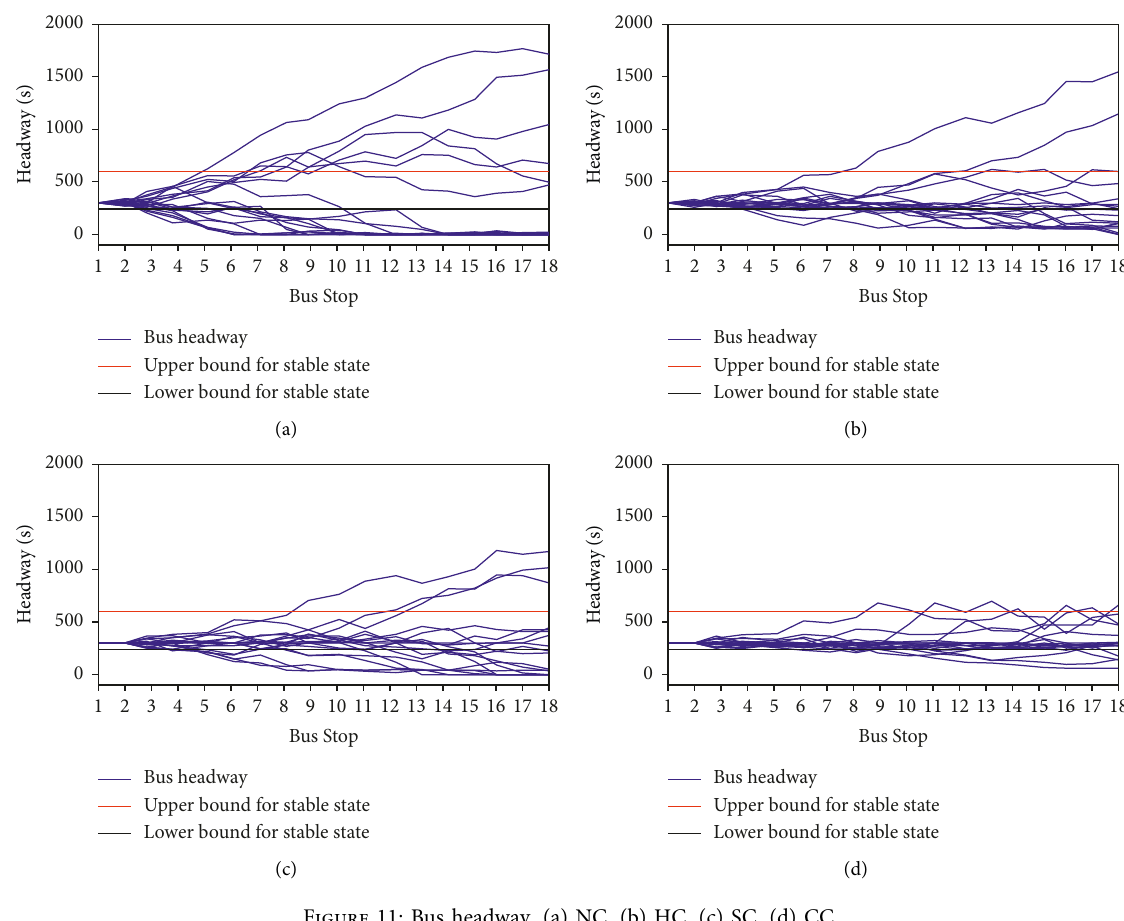
Figure 11: Bus headway. (a) NC. (b) HC. (c) SC. (d) CC.